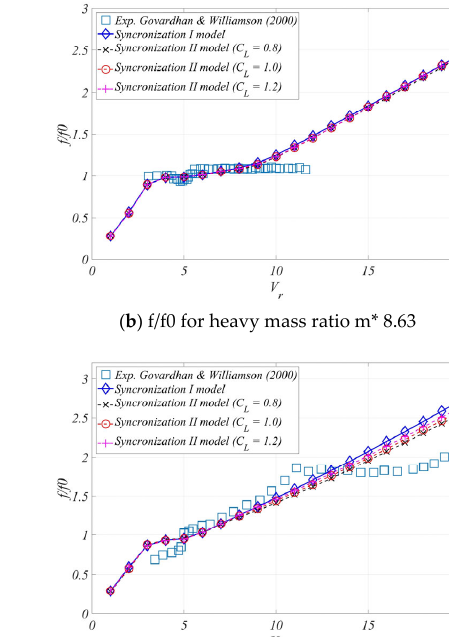
Figure 6. Forced oscillations of circular cylinder. Forced oscillations are also simulated with two types of synchronization models, the synchronization I model [25] and the synchronization II model [26], respectively. For the synchronization II model, 𝐶 (cid:3013) 0 and 𝐶 (cid:3005) are selected as 0.8 and 1.2 in the simulations of forced oscillations, based on simulation results of free oscillations. Table 2 shows simula ‐ tion conditions for forced oscillations of a circular cylinder. The calculated loads are non ‐ dimensionalized using Equation (5).